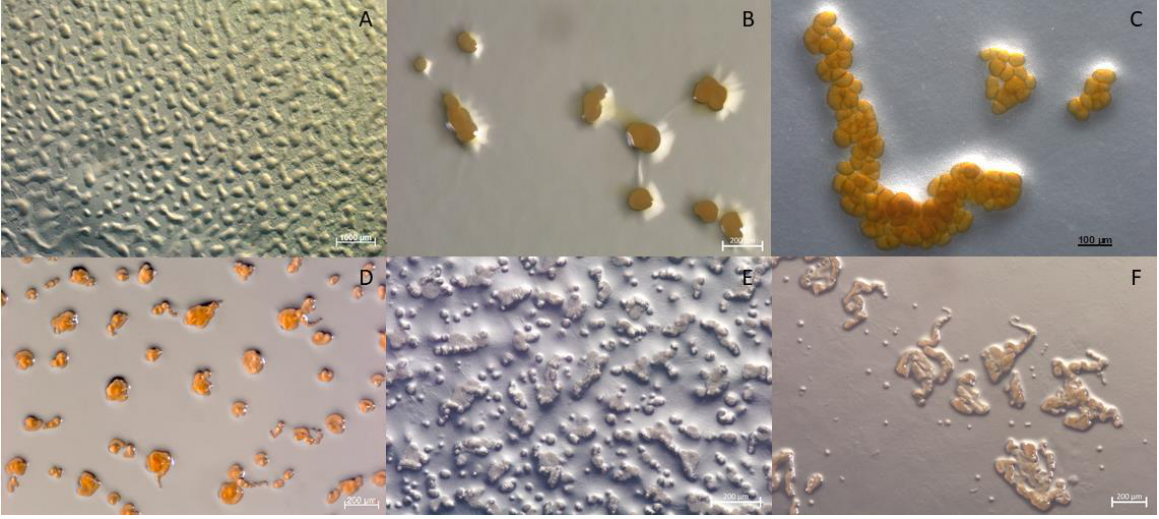
Figure 3. Comparison of fruiting body morphology observed from strains MCy9003 and MCy9049 to the related species in the family Myxococcaceae : ( A ) Strain MCy9003 fruiting body-like aggregates.